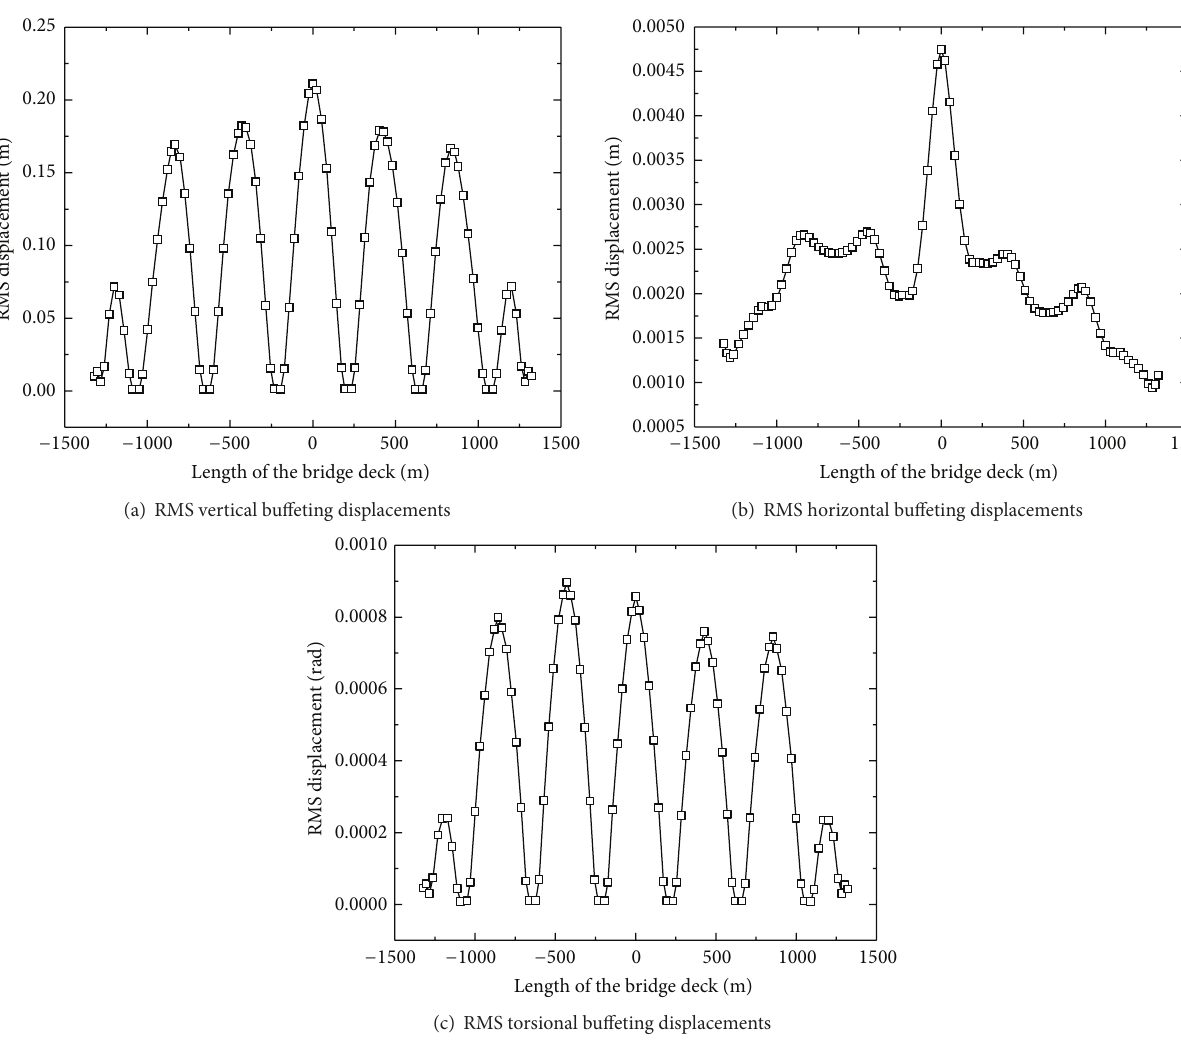
Figure 11: RMS buffeting displacements of the bridge